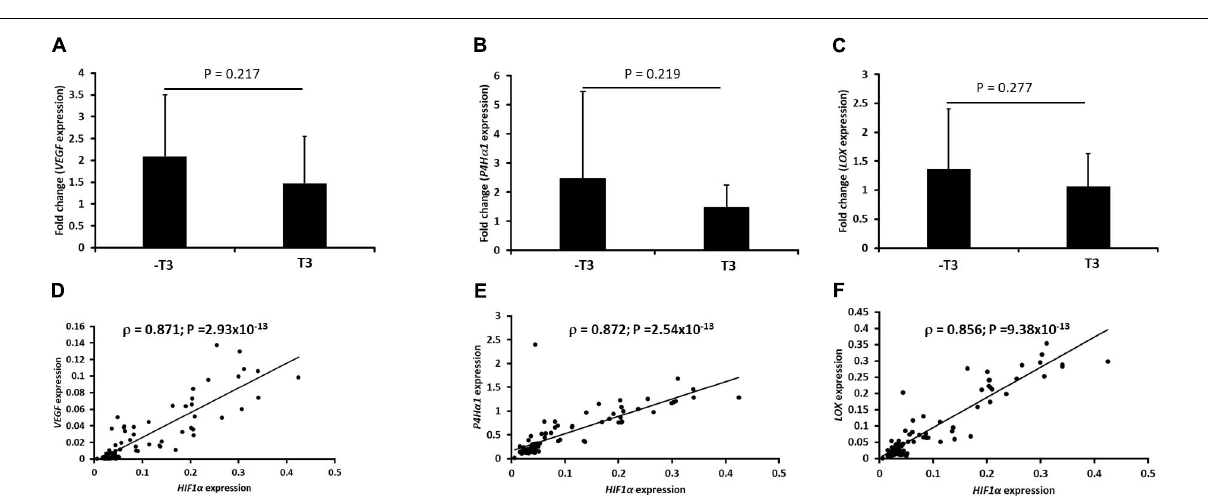
Frontiers in Cell and Developmental Biology |